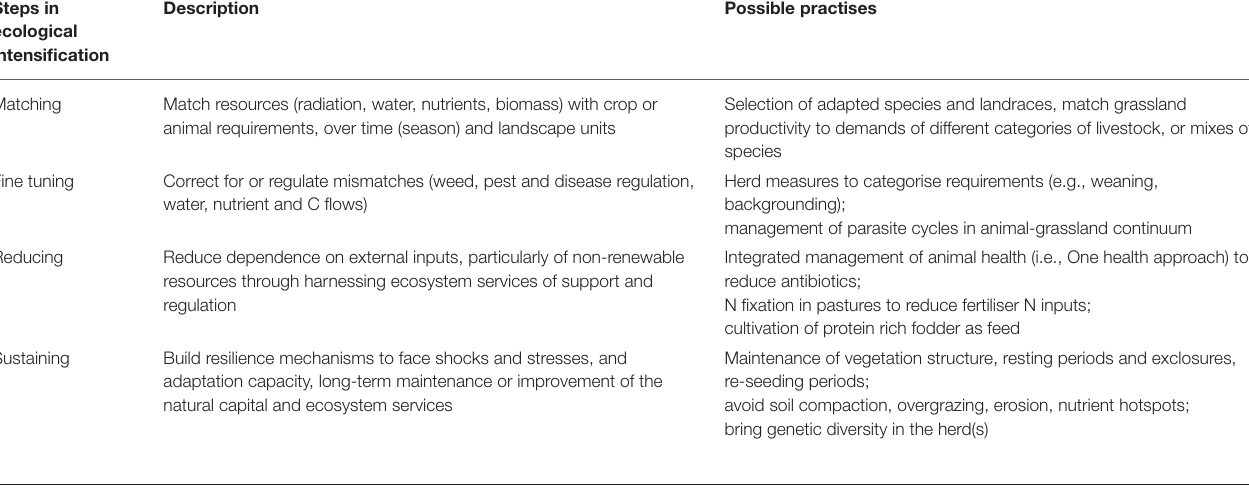
TABLE 1 | Four steps proposed for the ecological intensification of grazing livestock systems and examples of possible management practises. Steps in ecological